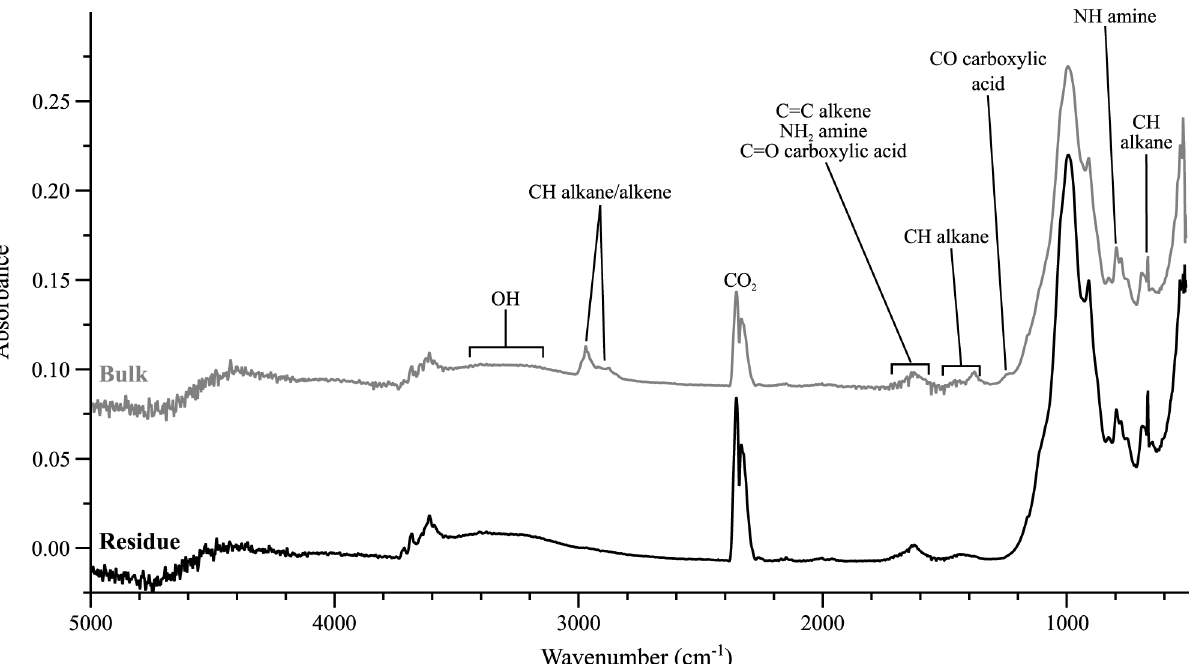
Fig 7. FTIR spectra of the bulk and residue of UOM-232. The major peak at approx. 1000 cm -1 is inorganic silica. Major components of both spectra include oxygen OH, alkene CH and C = C and NH and NH 2 amine groups. Signal at approx. 2300 cm -1 is atmospheric CO 2 . The major difference between the two is the lack of CH alkane/alkene groups in the residue, consistent with their removal during extraction.